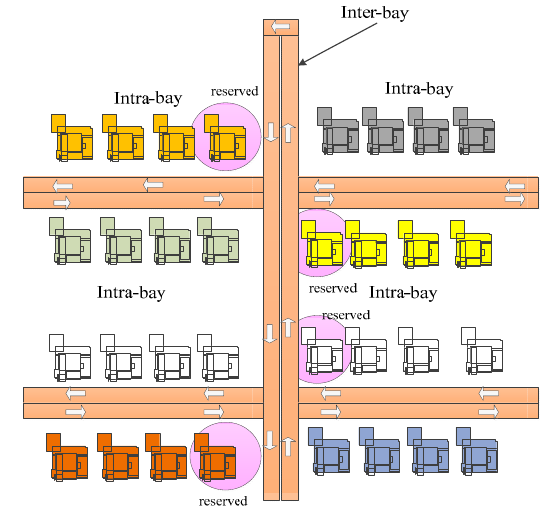
Figure 10. Reserve the nearest machine to the Intra-bay for hot lots.